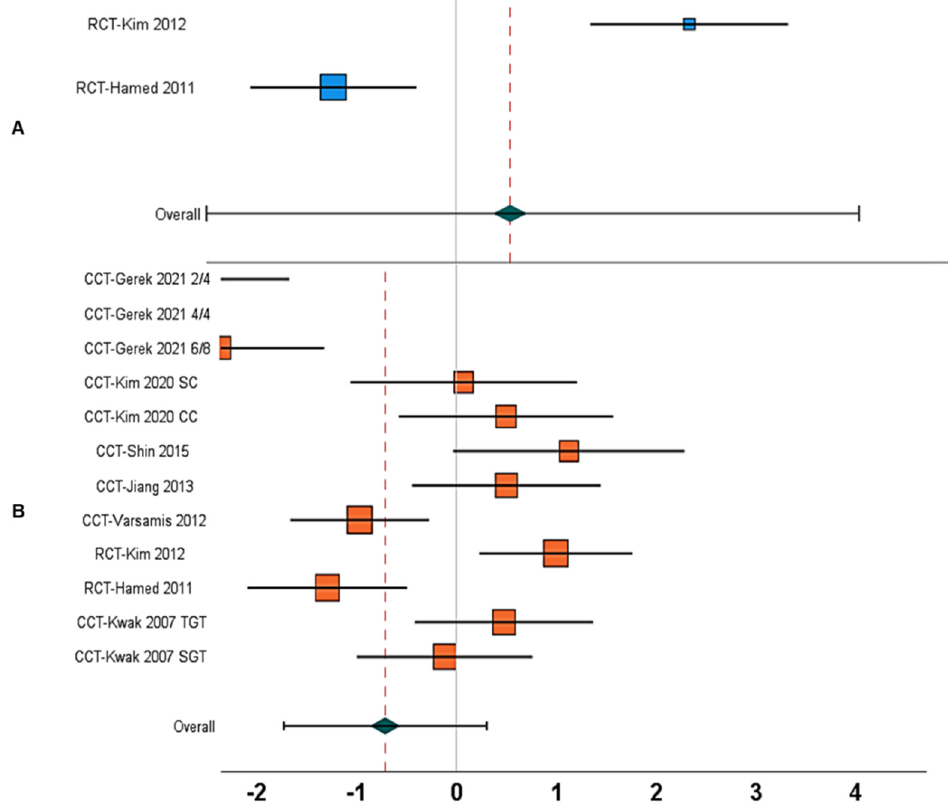
Figure 6. Forest plot illustrating the effect of AStim on cadence in people with cerebral palsy. The forest plots incorporate individual weighted effect size (Hedge’s g), which is represented as boxes (blue: between-group, orange: within-group), whereas the 95% confidence intervals are represented with whiskers. At the bottom, the pooled weighted effect size and 95% CI are represented with a green diamond. ( A ) In this analysis, a positive overall effect size means an enhancement in cadence for the AStim group, whereas a negative overall effect size indicates enhancements in cadence for the control group. ( B ) A positive overall effect size means an enhancement in cadence with AStim, whereas a negative overall effect size indicates reduction in cadence with AStim (RCT: Randomized controlled trial, CCT: Controlled clinical trial, NG: Normal gait, FG: Fast gait, TGT: Therapist-guided training, SGT: Self-guided training).